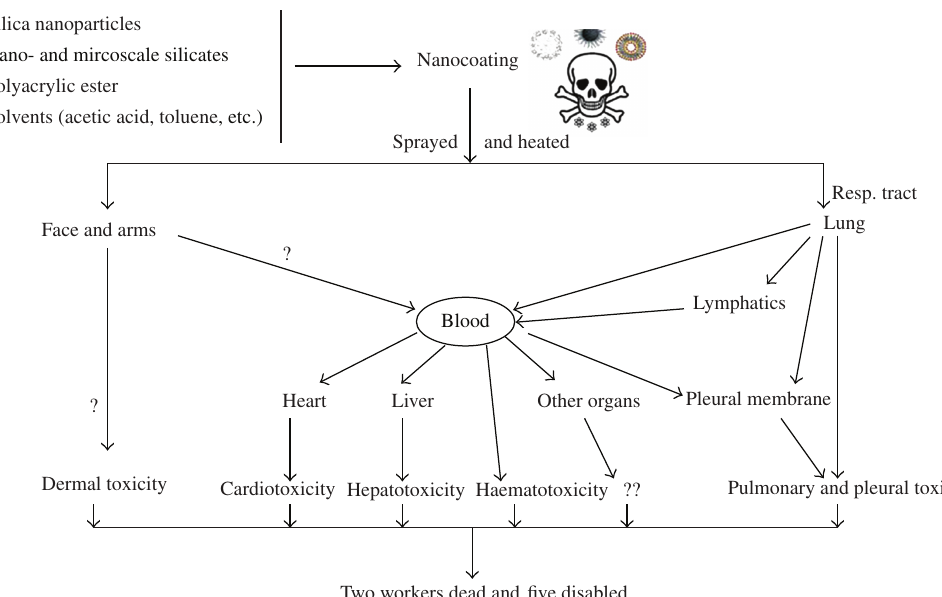
FIGURE 1: Potential translocation pathways of nanoparticles and the potential damage. Nanosilica and nanosilicates in the coatings may air in the workplace when sprayed, heated, and dried, then they deposit in the pulmonary alveoli when inhaled into the pulmonary respiratory tract, be taken up by macrophages, cross the lung epithelium, enter the pulmonary interstitial tissue, blood, and lymph, finally reach extrapulmonary organs, and result in multiorgan